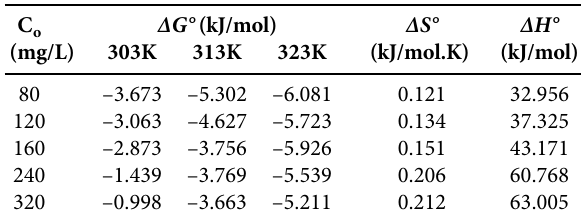
Table 6. Thermodynamic parameters.